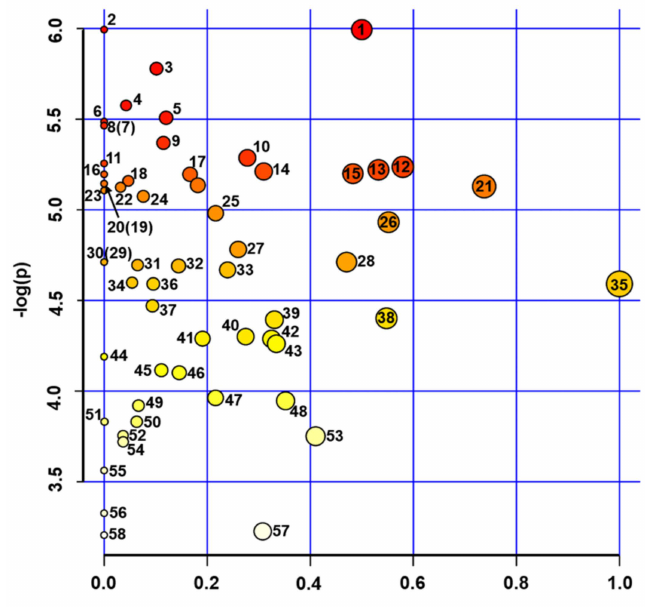
Figure 6. Pathway analysis accomplished for the drought-regulated (more than 1.5-fold, t -test p < 0.05, FDR adjusted at p < 0.1) primary polar metabolites of pea ( Pisum sativum L., cultivar SGE)